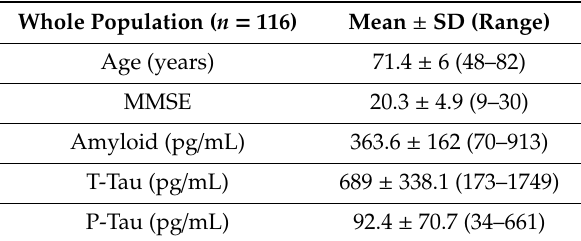
Table 1. A general overview of age, mini-mental state examination (MMSE), and Cerebral spinal fluid (CSF) parameters in the whole population.